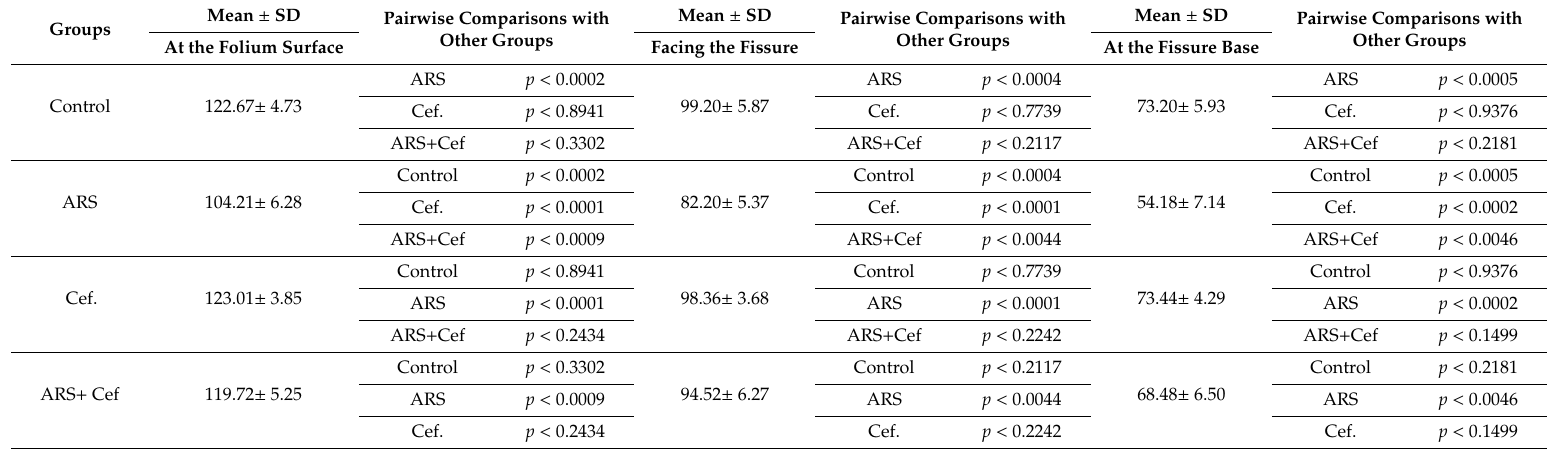
Table 6. Morphometric analysis of the granular cell layer thickness at three di ff erent areas of the cerebellar